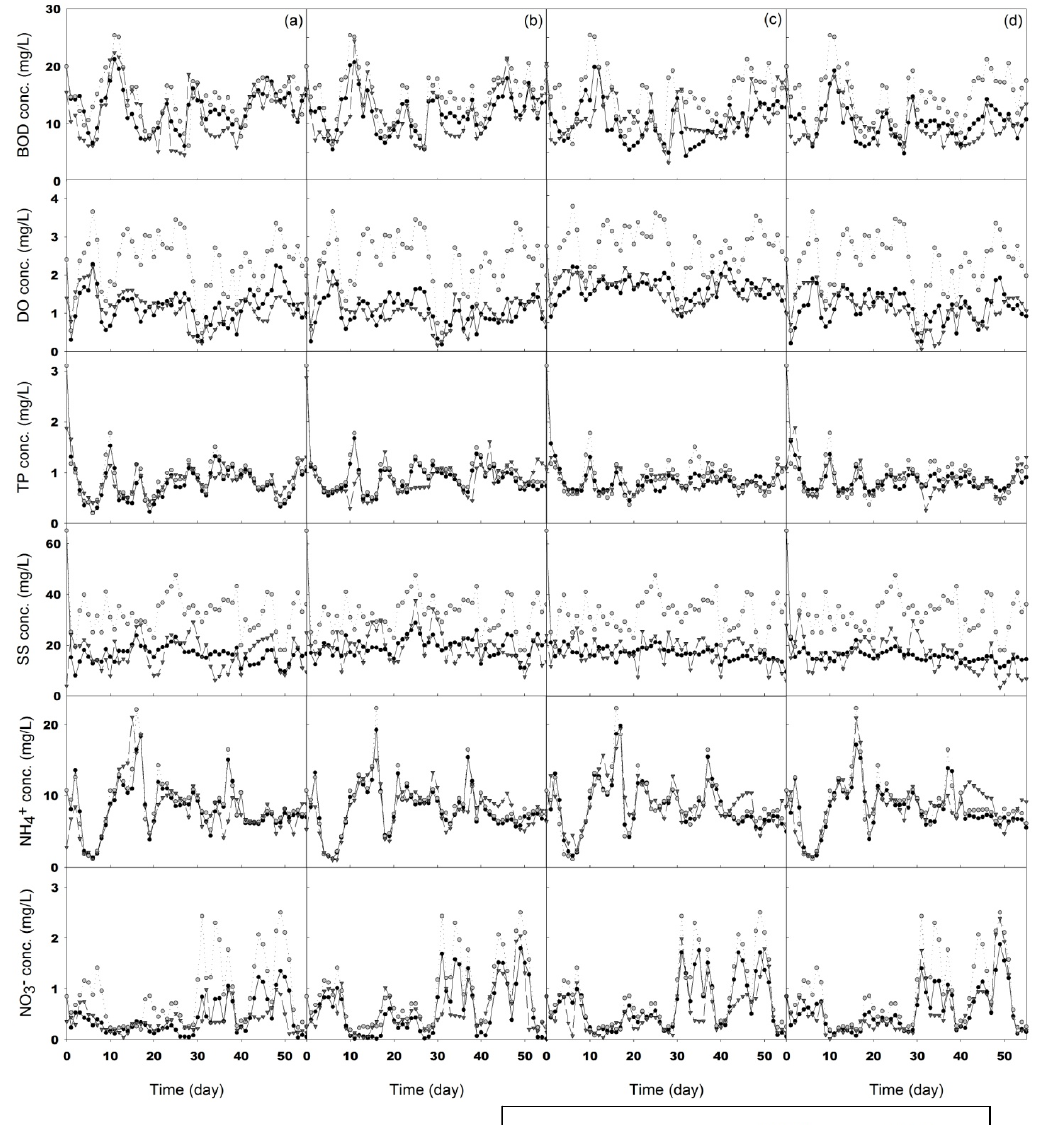
Figure 3. Simulated BOD, DO, TP, SS, NH 4+ and NO in ( a ) HA; ( b ) HB; ( c ) VA; and ( d ) VB